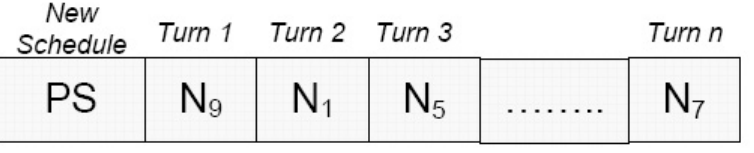
Figure 2. Example of a key management schedule with n